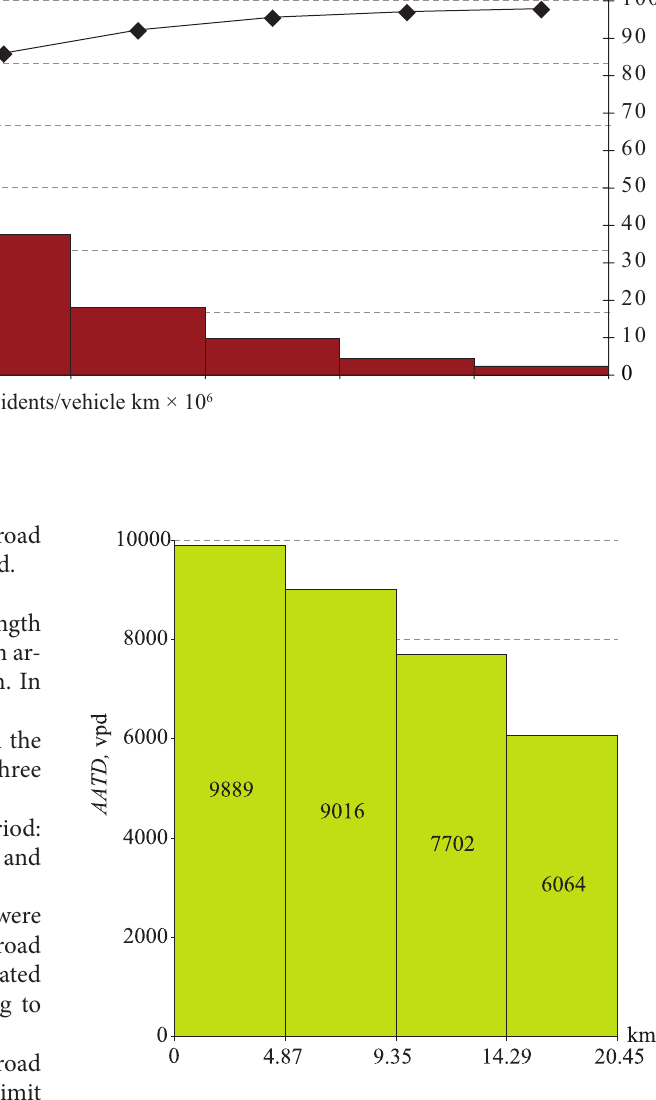
Fig. 3. AADT on state main road A4 Rīga bypass